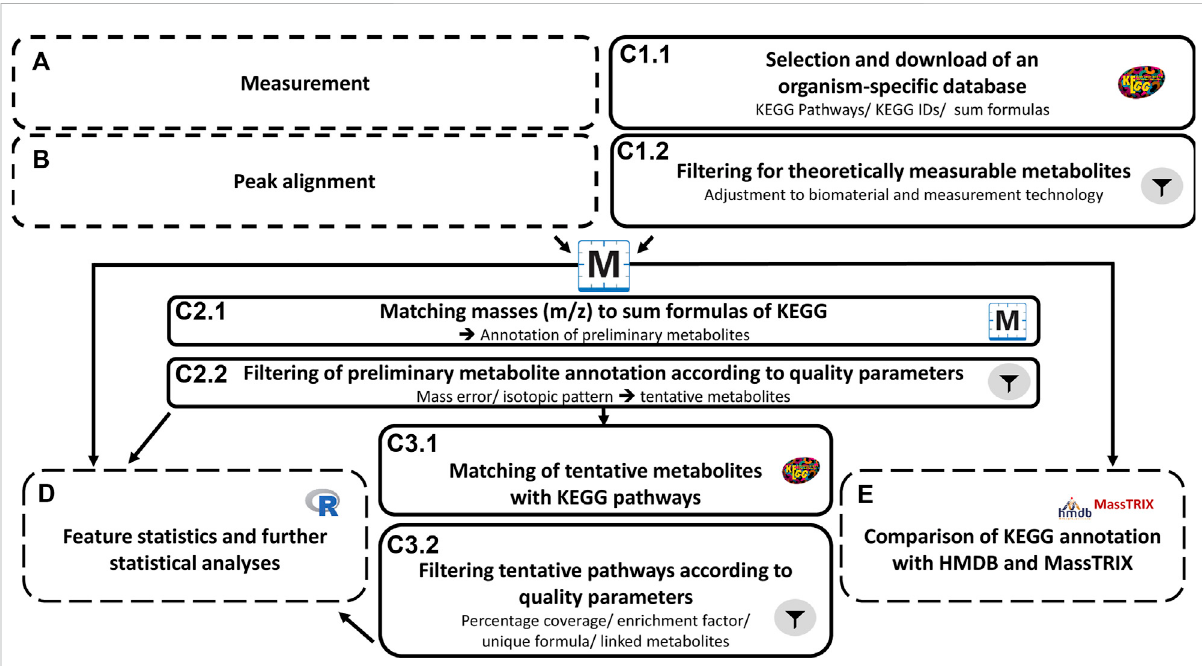
FIGURE 1 Work fl owmetabolomicsapproach.Themetabolomicswork fl owwasdividedinto fi vemainsteps (A – E) .Samplesweremeasured (A) andsignals werealigned via instrument-speci fi csoftware (B) .Thedataanalysis (C) wasfurtherdividedintosixsteps.Thisincludedtheselectionanddownloadof an organism-speci fi c database, metabolite annotation and pathway mapping, and in addition, speci fi c fi lter elements with adjustments regarding biomaterial and measurement technique (C.1.2/C2.2/C3.2) to reduce false-positive results. In parallel with metabolite annotation, feature statisticswereperformed (D) basedonexportedbuckettables afterstepB.Thesedatawerealso usedfor comparative analysesinwebdatabases (E)